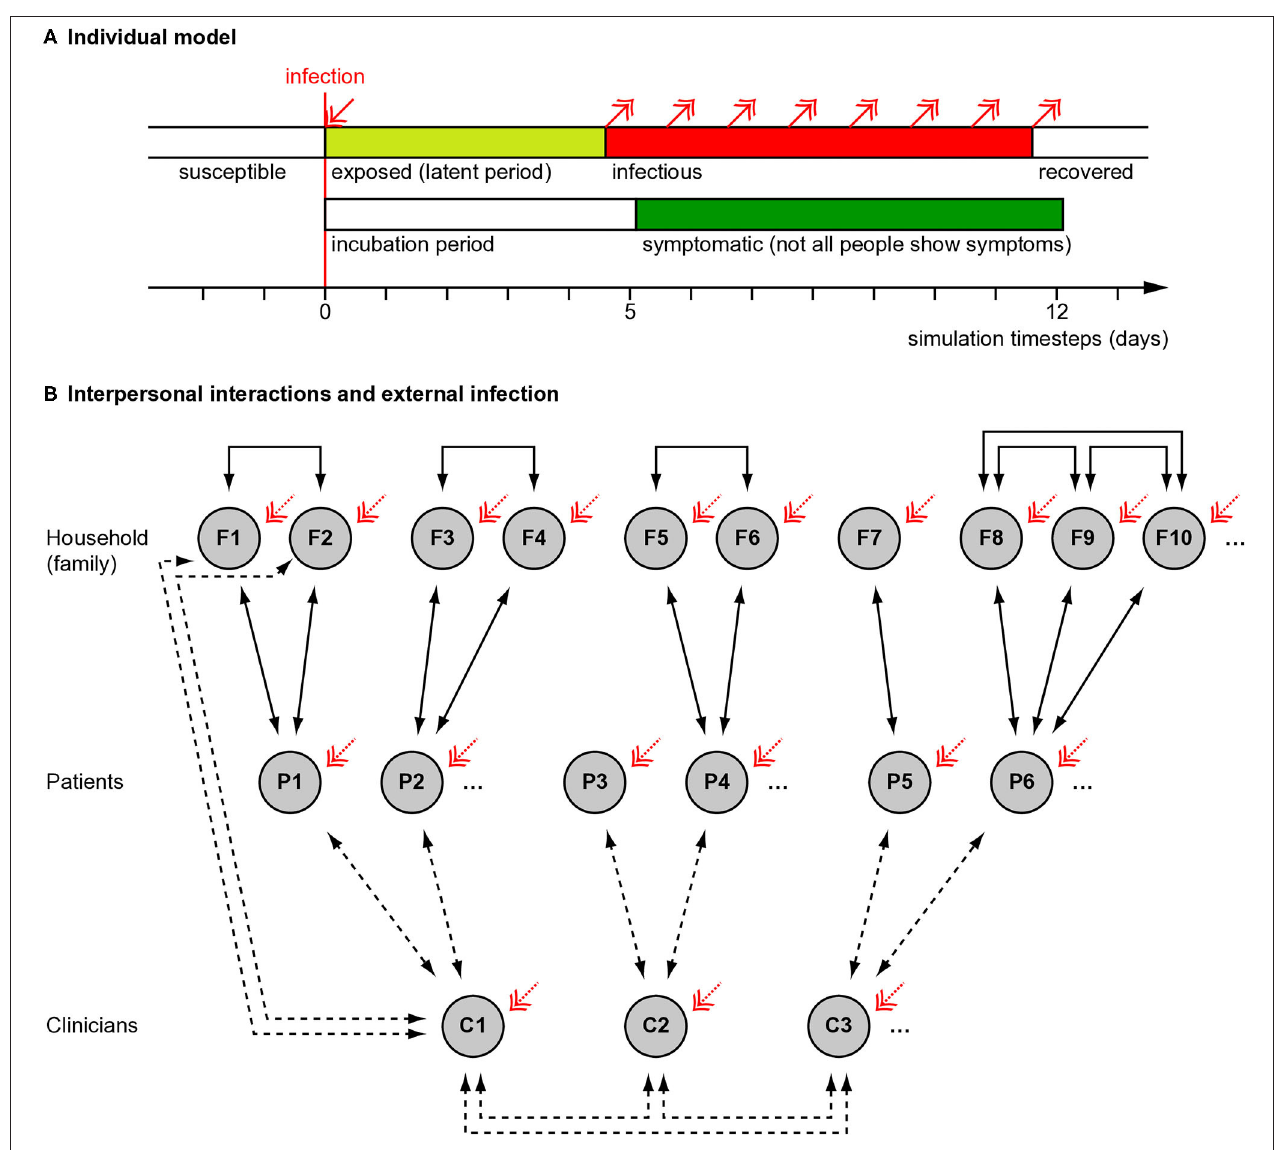
FIGURE 1 | Overview of simulation methods. (A) Individual people followed a “susceptible–exposed–infectious–recovered” model, with full immunity after recovery. Whether an infected person developed symptoms or not was probabilistic (see Methods) and if they developed symptoms, this occurred slightly after the infectious period began. (B) Interaction between people (see Methods). Solid lines show fixed interactions; dashed lines show interactions that were varied. Patients interacted with their household (family) members and family members interacted with each other. Family sizes varied. In different conditions, clinicians did or did not interact directly with each other. Clinicians interacted with their patients, except in the “remote visit” condition. In the “family contact” (e.g., home visit) condition, clinicians also interacted briefly with family (not all such interactions drawn). The initial level of infection and the rate of ongoing “external” infection (red arrows) were varied. Additional manipulations, not shown here, included whether symptoms altered infectiousness in a behavioural, protective way (in contrast to an ever-present biological exacerbating way) and, in Experiment 2, whether patient households were grouped together in larger clusters with mutual interaction.